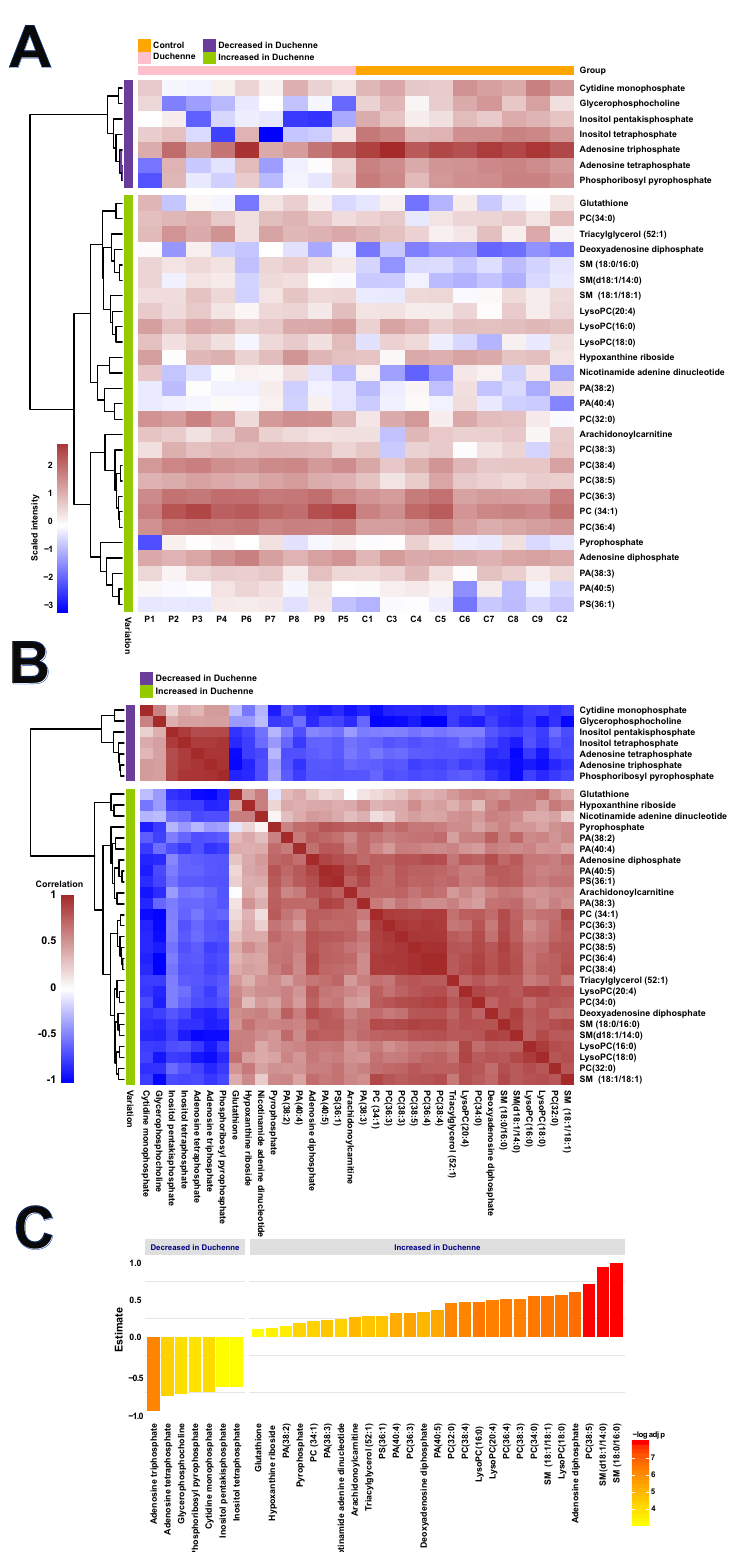
Figure 2. Metabolome variations between DMD and control tissues. ( A ) Unsupervised hierarchical clustering based on metabolic profiles (34 metabolites) detected in 9 DMD and 9 control tissues. C: Control, P: Patient; ( B ) Spearman correlation heatmap of the 34 differentially expressed metabolites between control and DMD tissues; ( C ) Barplots of the differentially expressed metabolites and their directional changes in the DMD tissues. Bar color is proportional to –log (adjusted p-value). Red denotes high